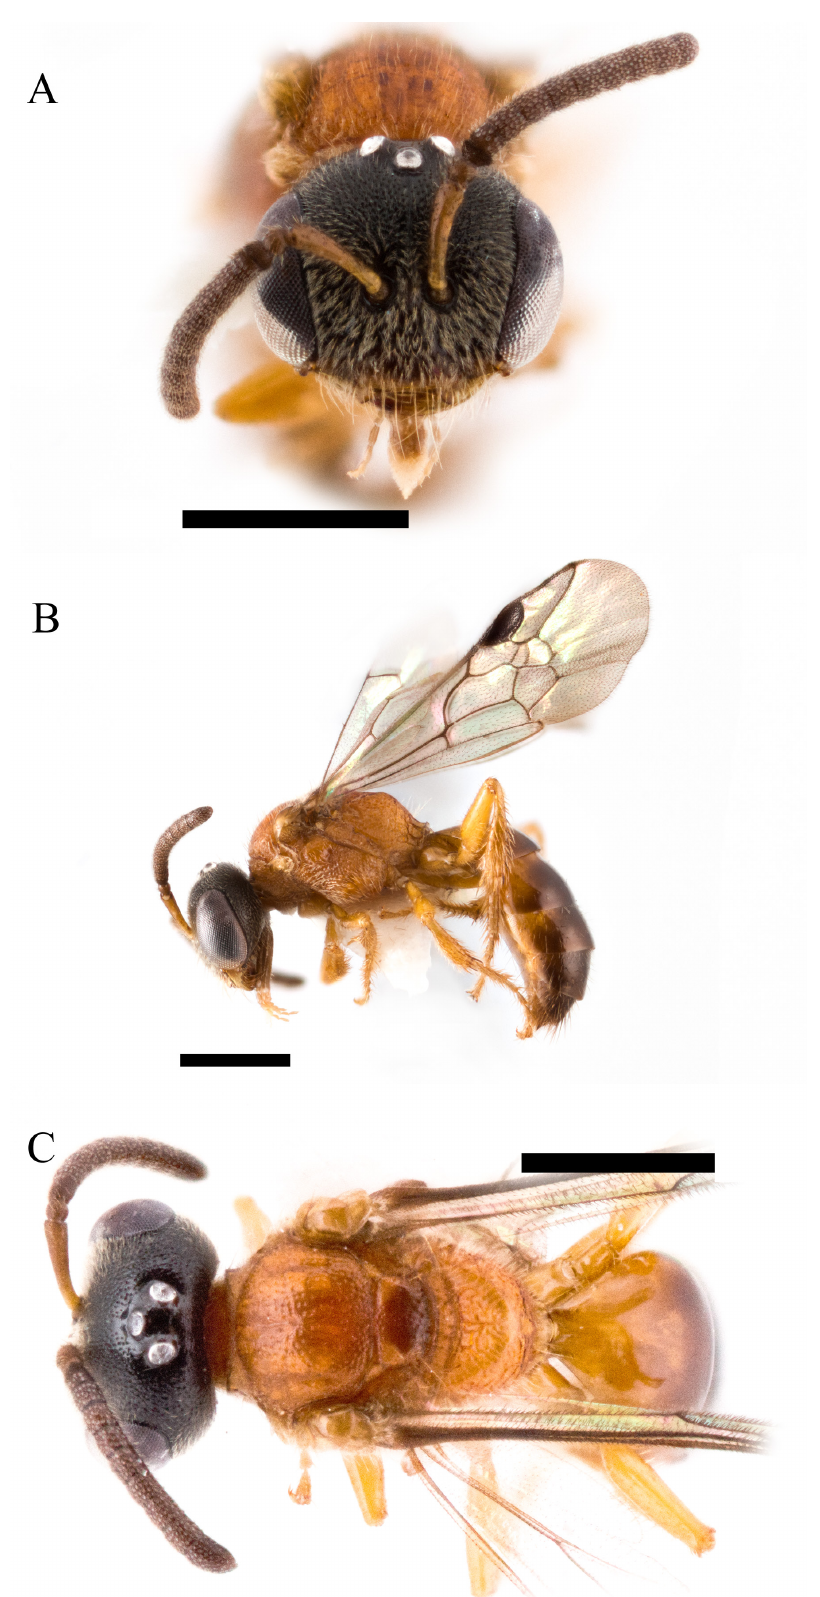
Fig. 15. Microsphecodes dominicanus (Stage, 1972), ♀. A . Face. B . Lateral habitus. C . Dorsum of mesosoma. Scale bars = 1